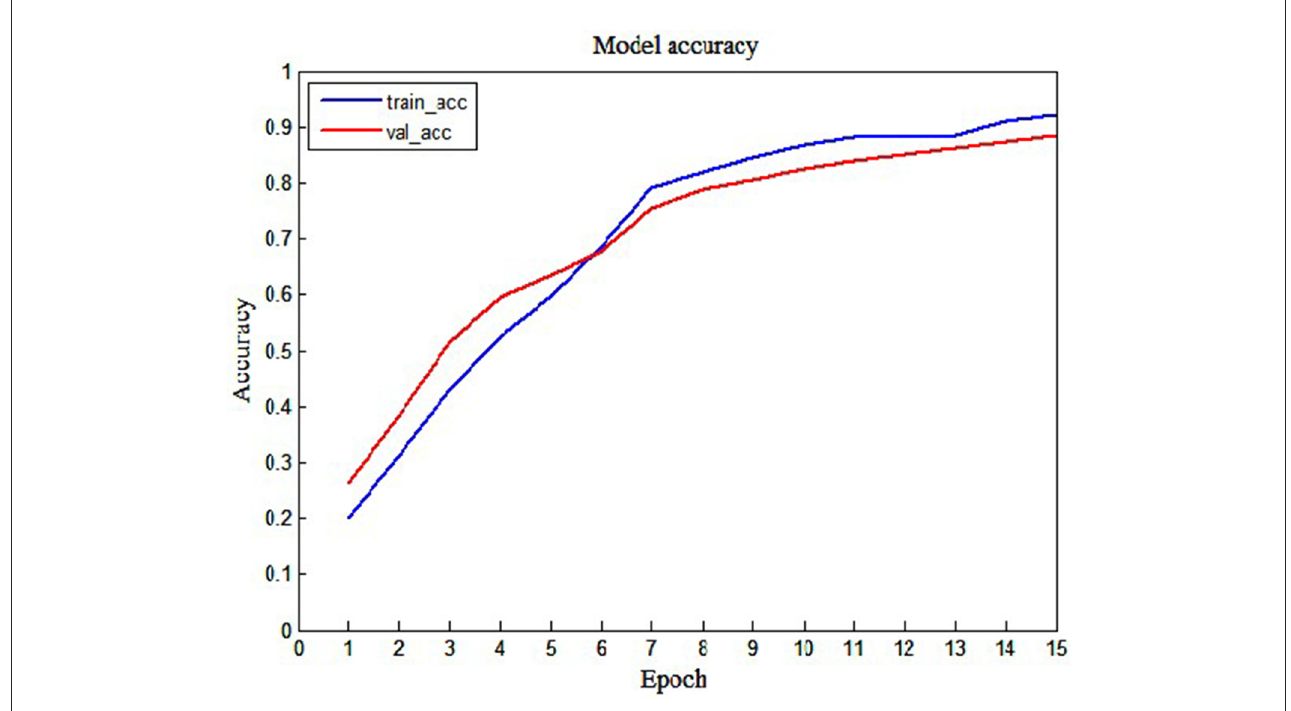
FIGURE8 The training accuracy and validation accuracy of the LSTM